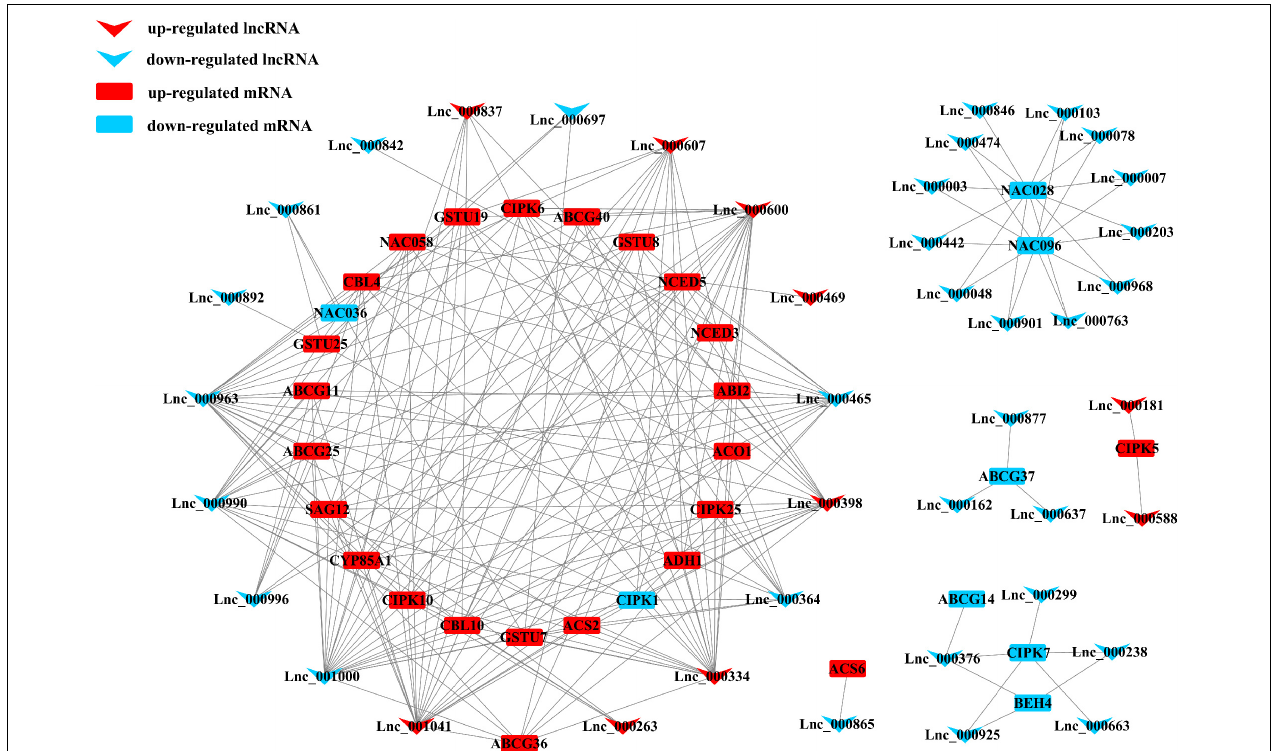
FIGURE 5 | Representatives of the interaction networks among lncRNAs and target protein-coding genes in S. pennellii . Red down arrows refer to up-regulated lncRNAs, blue down arrows refer to up-regulated lncRNAs. Red rectangles refer to up-regulated mRNAs, blue rectangles refer to down-regulated mRNAs.